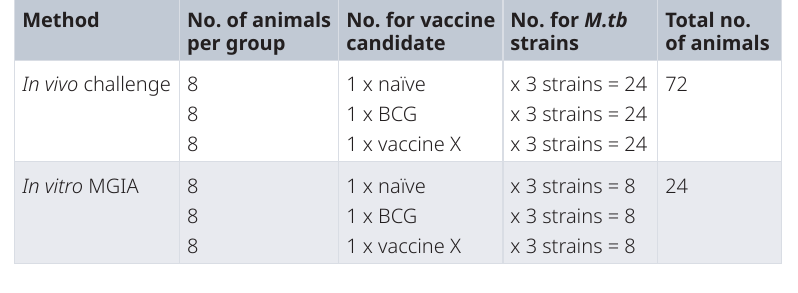
Table 1. A hypothetical experimental design demonstrating the numbers of animals required for in vivo challenge vs. in vitro MGIA